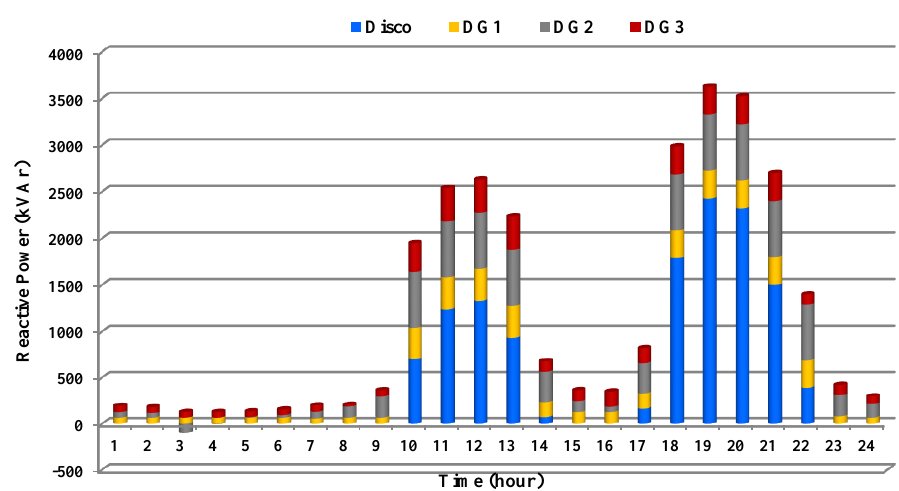
Figure 9. Daily optimal reactive power dispatches of generation units in Scenario 1.